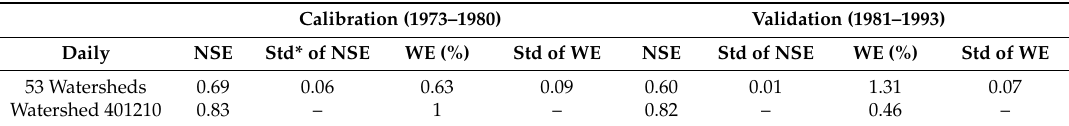
Table 4. The average statistical parameter values for 53 watersheds in calibration and validation.